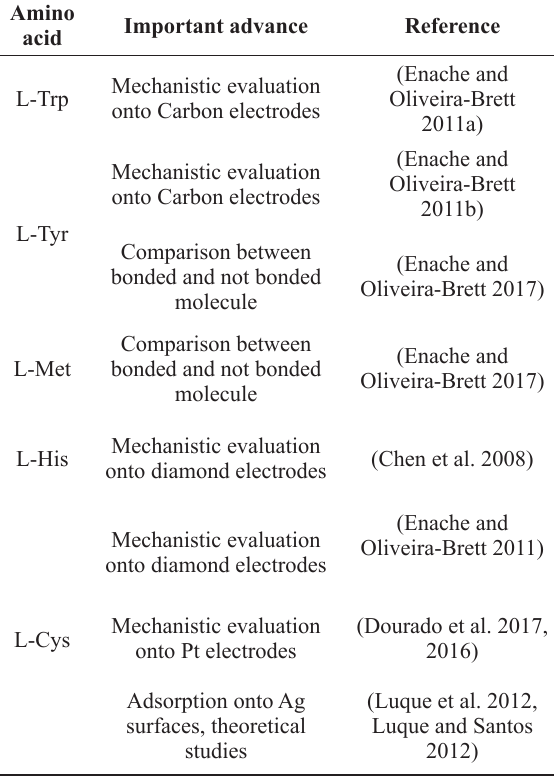
The most recent efforts in the study of electroactive amino